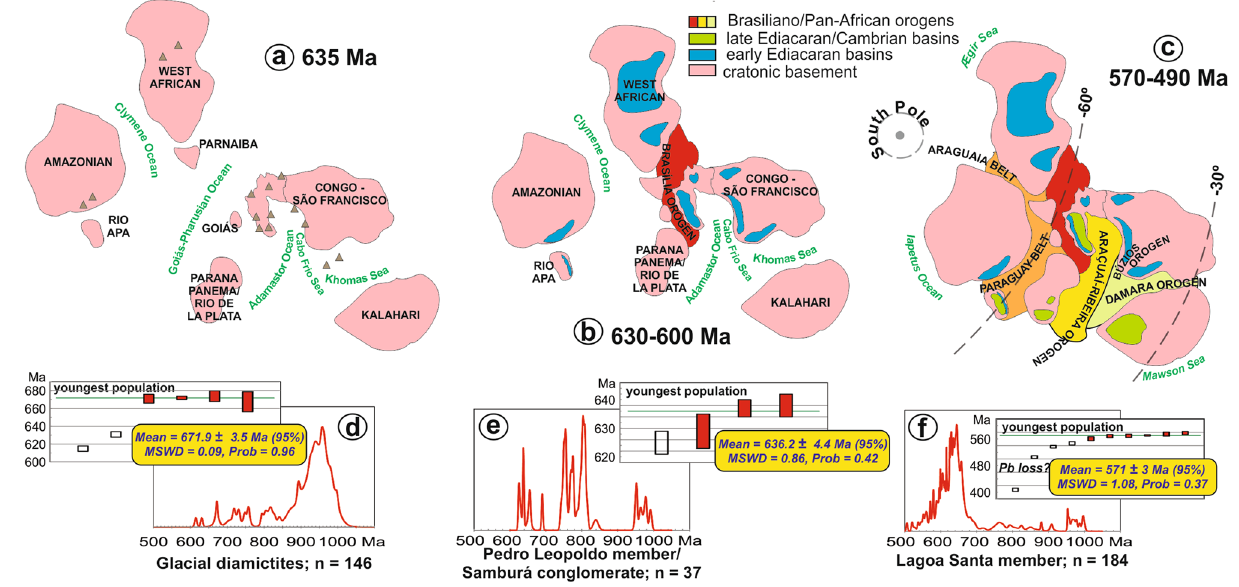
Figure 6. Integrated evolution of Ediacaran–Cambrian orogens and basins in western Gondwana. In ( a – c ) schematic models of evolution of western Gondwana during the late Ediacaran-early Cambrian. In ( d–f ) literature-compiled Neoproterozoic detrital zircon 206 Pb/ 238 U age spectra for the Bambuí basin during each of the stages depicted in ( a–c ) respectively. Approximated paleolatitudes in c from 37 . Charts were created using